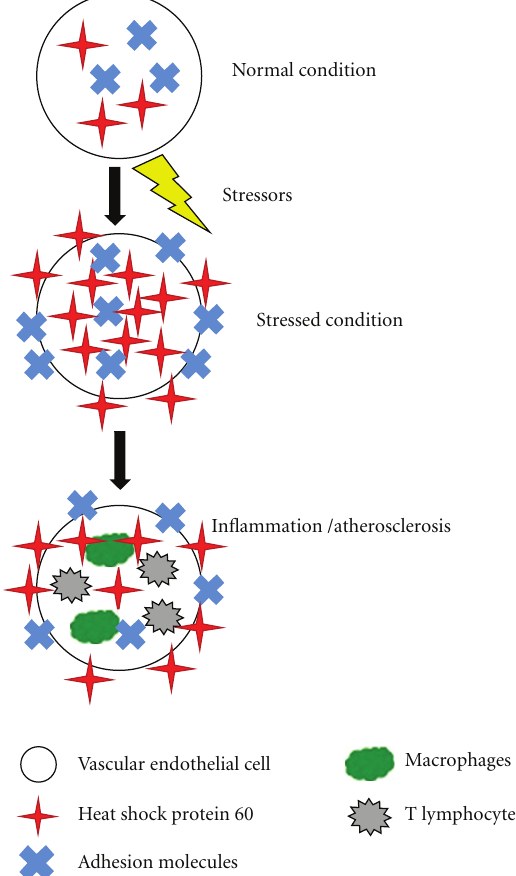
Figure 1: Concept of autoimmunity towards heat shock protein 60 and the development of atherosclerosis. Under normal conditions, heat shock protein 60 is located intracellularly and is not expressed on the vascular endothelial cell surface. Under stressed conditions, heat shock protein 60 and various adhesion molecules are upregu- lated and expressed on the cell surface. This leads to inflammation and the development of atherosclerosis.